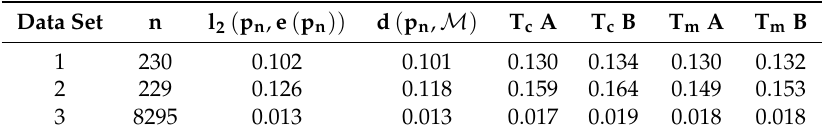
Table 2. Minimum tolerance parameter ε , for which H 0 can be rejected at the nominal level 0.05. A stands for the asymptotic test and B stands for the bootstrap